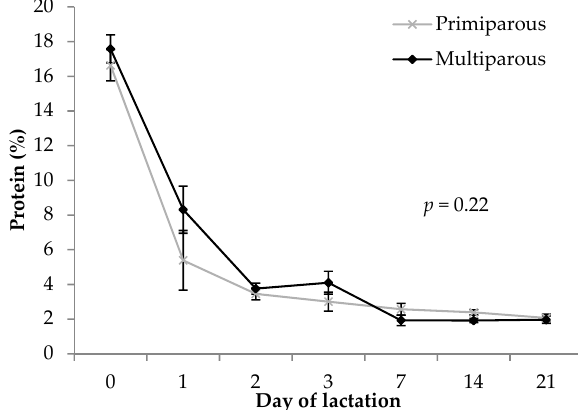
Figure 2. Comparison of total protein concentration (%) in colostrum and milk between primiparous and multiparous sows. The p- value stated is the effect of the parity by timepoint interaction. Error bars represent the standard error of the mean ( ± SEM).